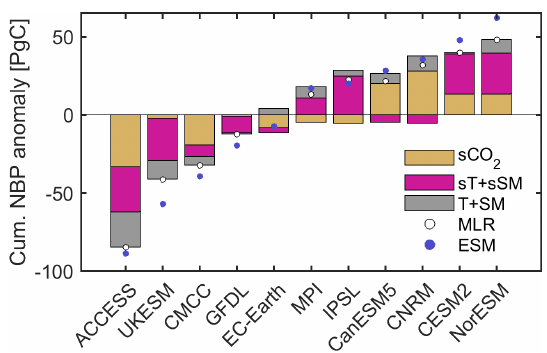
Figure 8. Summary of the contributions of the drivers to explain- ing intermodel differences in projected global land cumulative NBP. Bars indicate the grouped contributions of sCO 2 , sT plus sSM, and T plus SM to the NBP anomaly estimate from the multiple linear regression. Dots indicate the total NBP anomaly based on the multiple linear regression (MLR) and from the actual model pro- jections (ESMs). All values correspond to averages from the 200 bootstrap samples. Global land estimates are obtained by multiply- ing the area-weighted averages by the land surface area excluding Antarctica (135.22 × 10 6 km 2 ). From left to right the models are ordered according to actual increasing projected land carbon